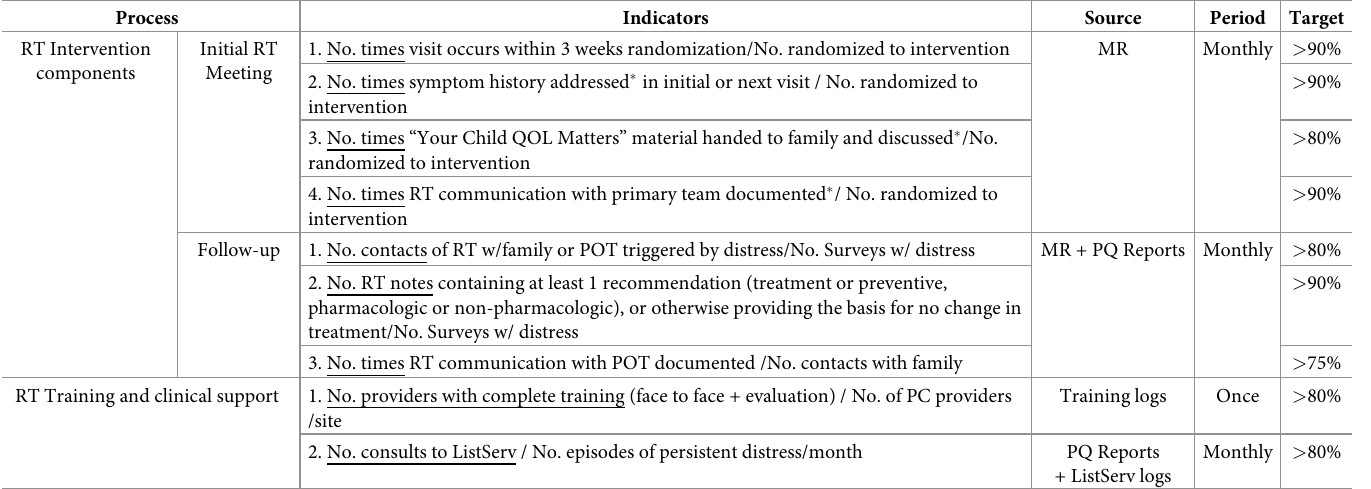
Table 2. Intervention fidelity